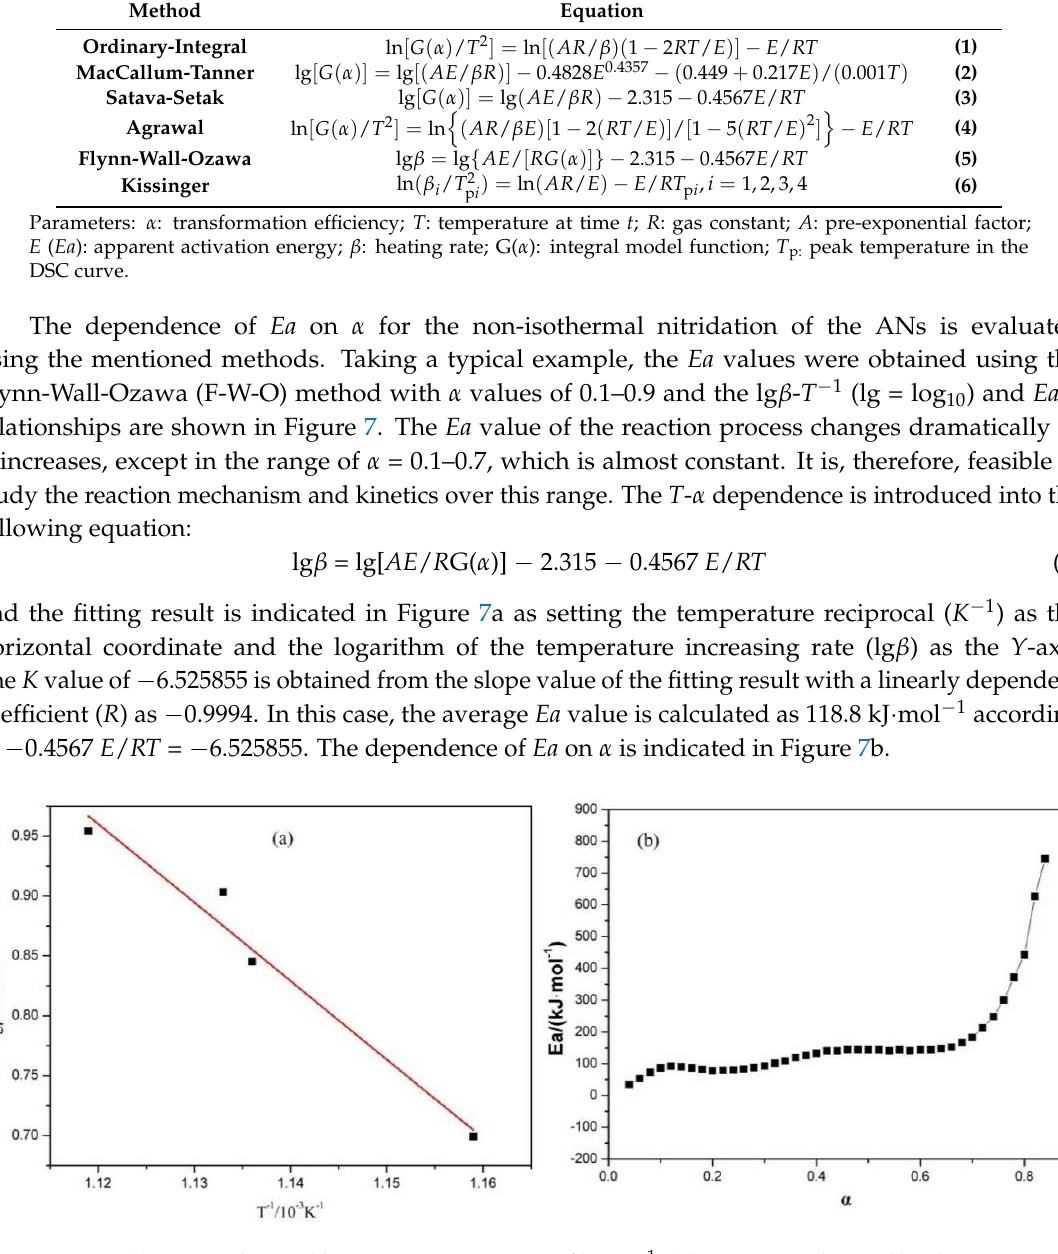
Figure 7. ( a ) Scatter plots and linear regression curves of lg β - T −1 ; ( b ) Ea - α curve obtained by the F-W-O method with R = −0.9994.